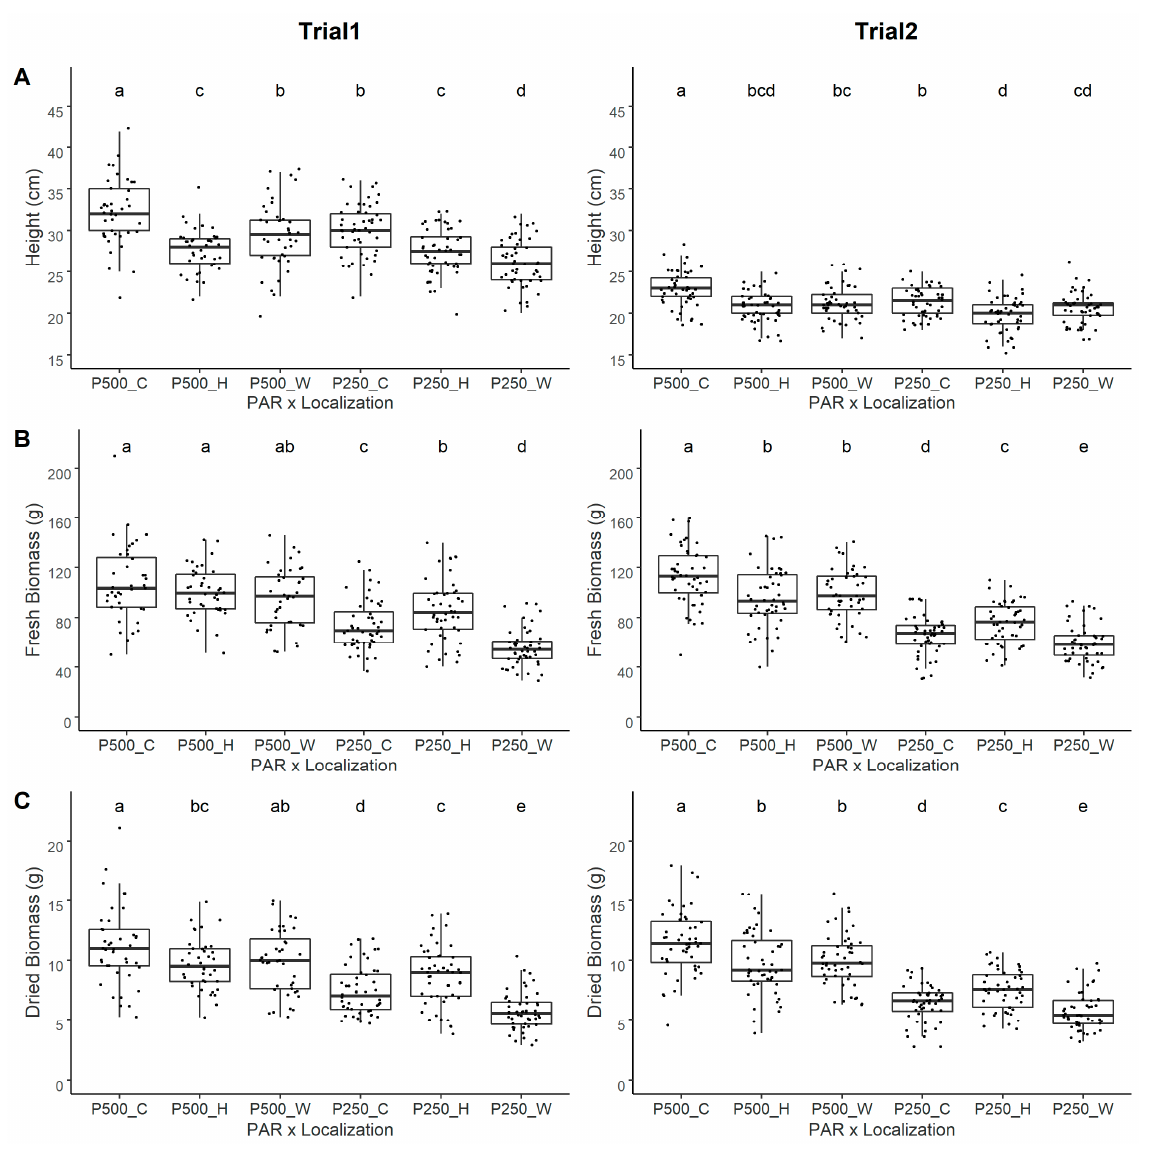
Figure 4. Boxplot of Euphorbia peplus height ( A ), fresh biomass ( B ), and dried biomass ( C ) under the interaction of light intensity (P250: 250 PAR; P500: 500 PAR) and the plant localization in the cultivation tray (W: wall; C: center; H: alley) in two independent experiments. Wilcoxon’s comparison of medians was applied with 95% confidence; medians that do not share a letter are significantly different. Trial 1: PAR 250: N = 48 plants per localization; PAR 500: N = 40 plants per localization. Trial 2: N = 48 plants per localization and light intensity.